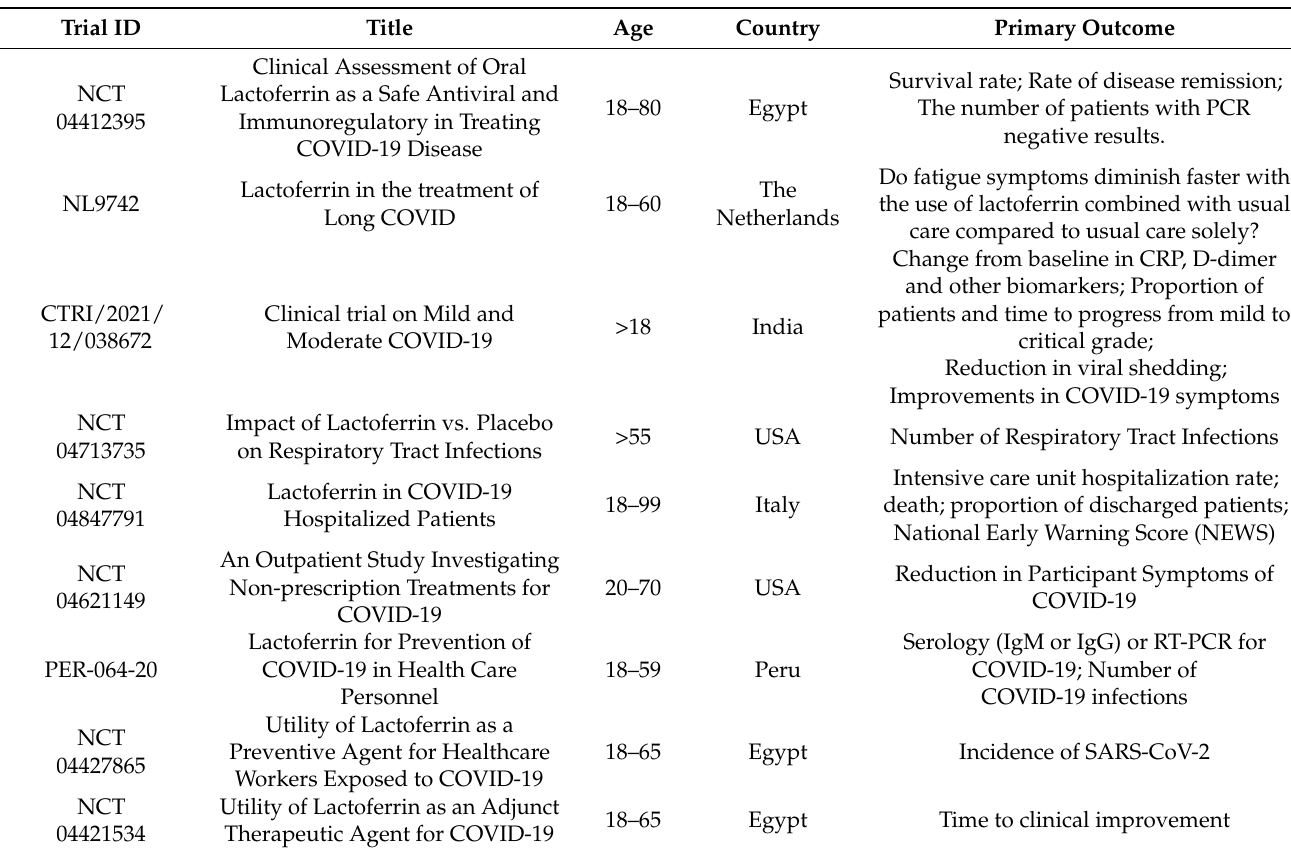
Table 6. Registered LF intervention trials in COVID-19 patients in WHO international trial reg- istry